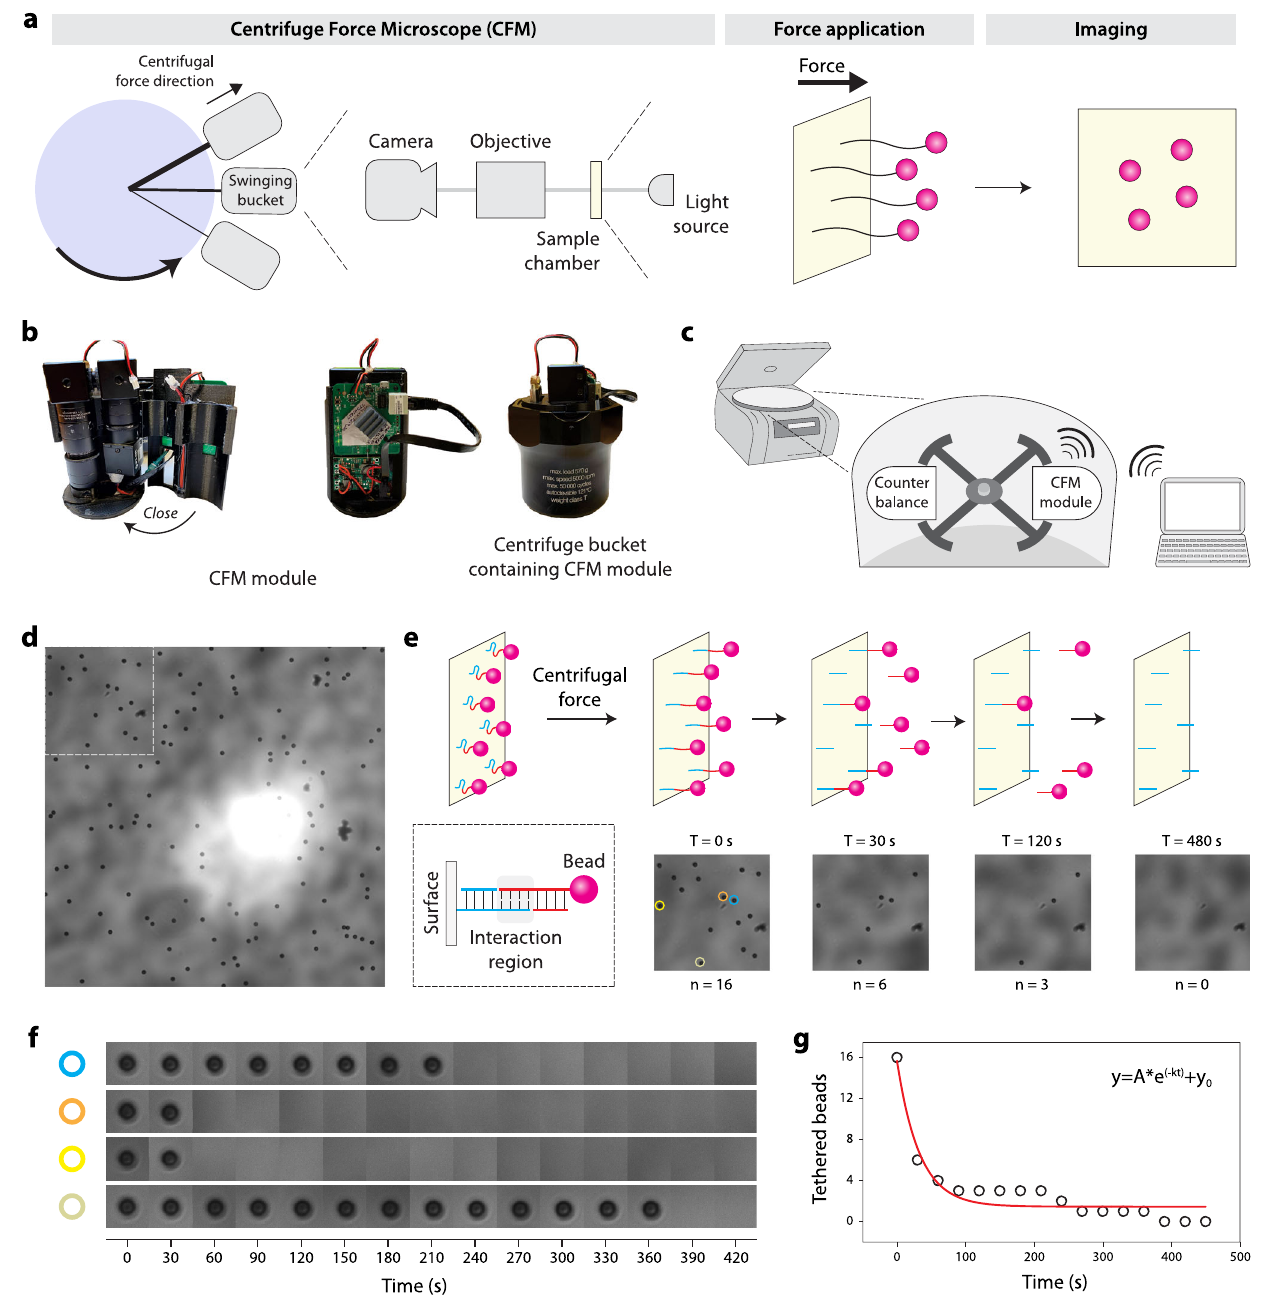
Fig. 2 | Concept of the centrifuge force microscope (CFM) and force clamp assay. a The CFM is comprised of a video microscope that is centrifuged. Cen- trifugal force is applied to tethered microspheres and aligns with the imaging pathway to give a headon view of microspheres. b Images of the custom